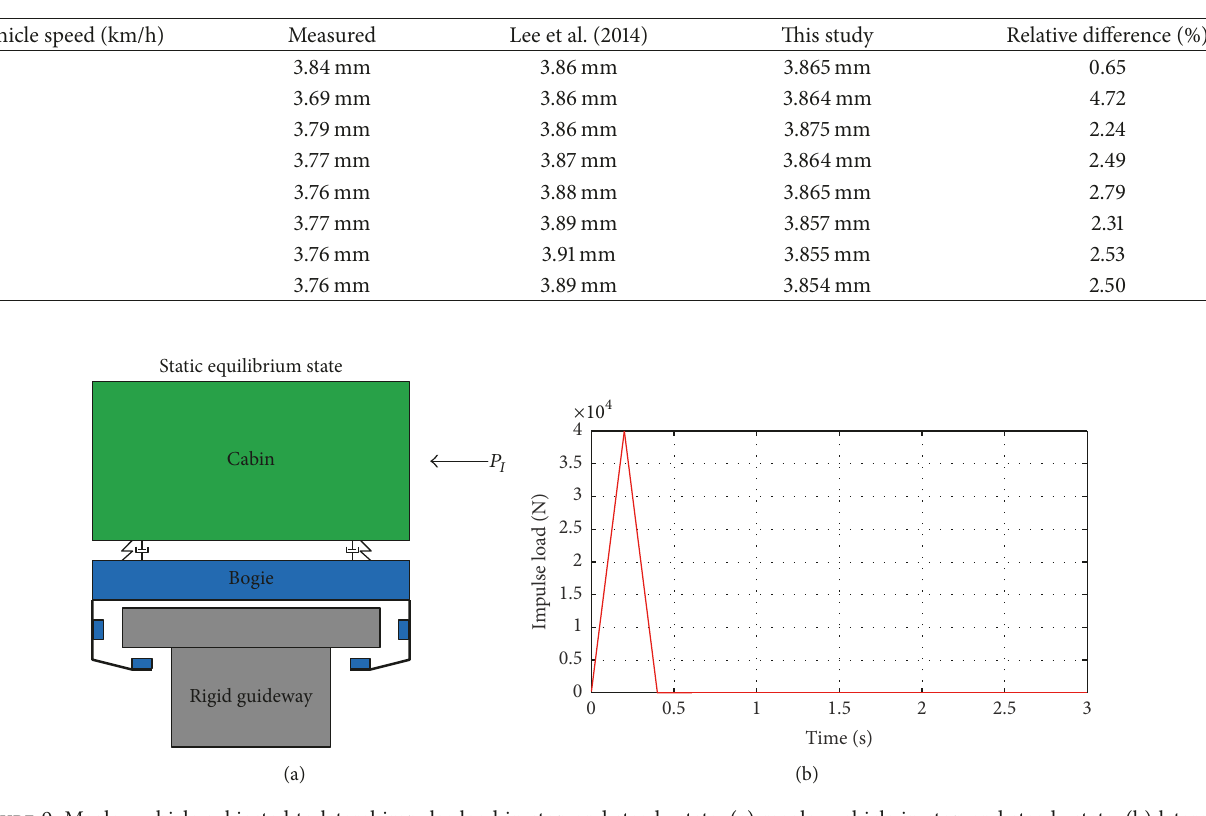
Table 7: Comparison of numerical analysis with field test data for maximum displacement.